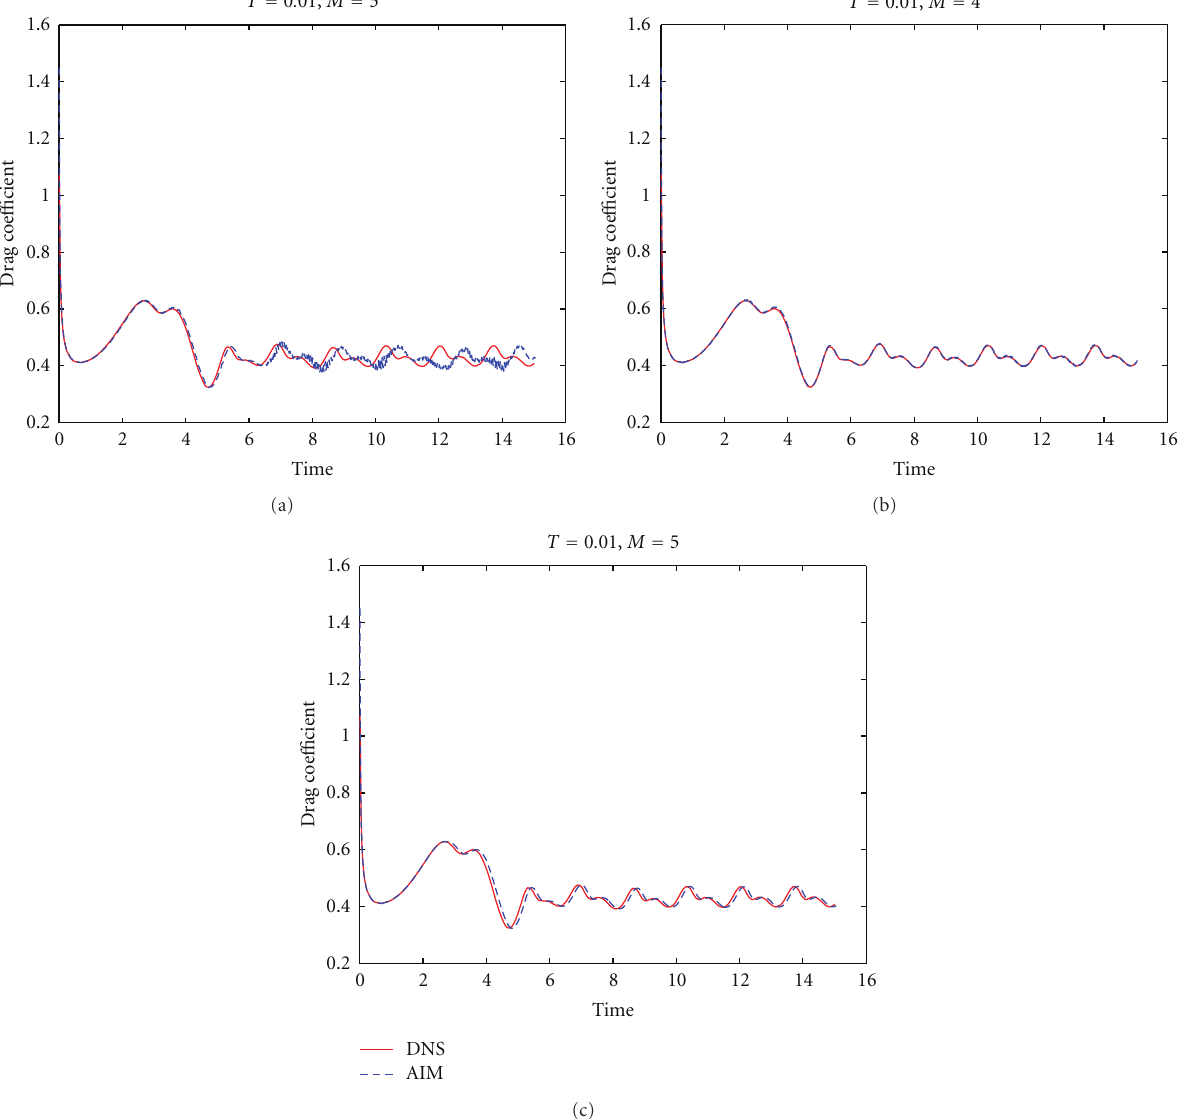
di ff erent from our present method. We will provide more details of restriction and lifting processes for solving the incompressible flows in the next